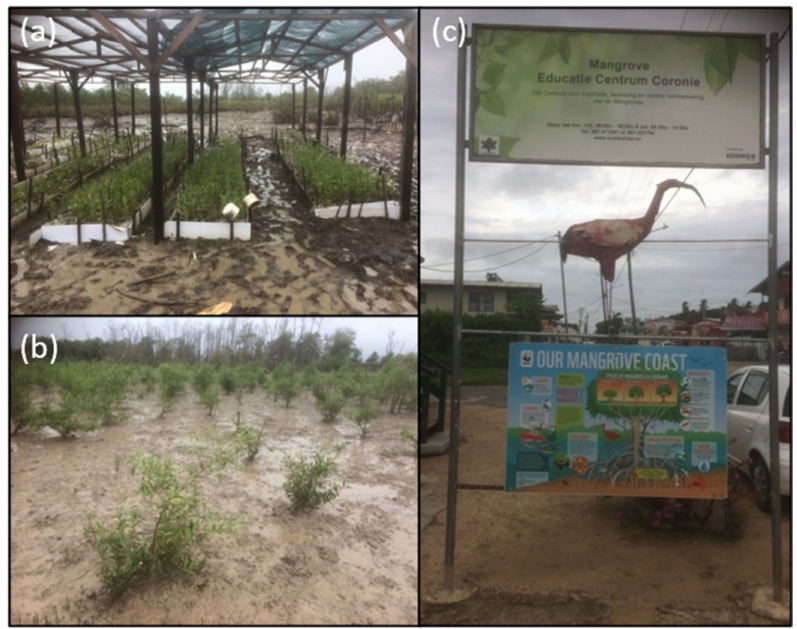
Figure 9. ( a ) Mangrove nursery and replanted plot ( b ) in Paramaribo, at the initiative of Professor Sieuwnath Naipal, Anton de Kom University, Paramaribo, Suriname, and ( c ) a mangrove school in Coronie,